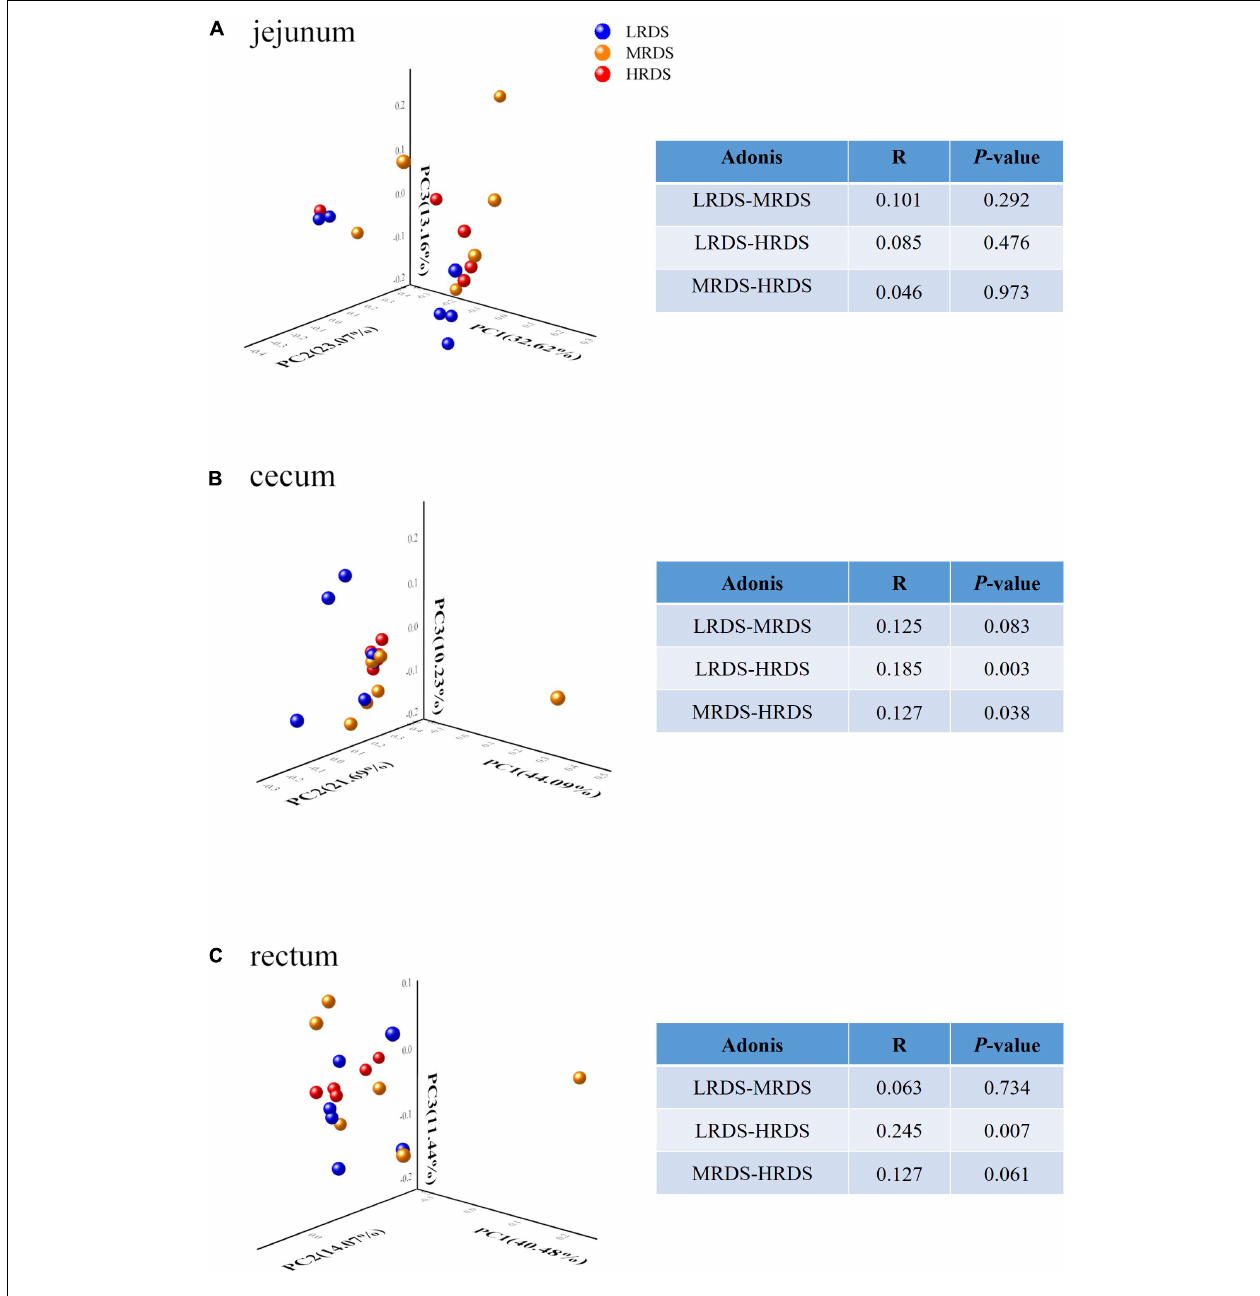
FIGURE 1 | Microbial community difference among different groups in the jejunum microbiome (A) , but showing obvious dysbiosis over positions in the cecum (B) and rectum microbiome (C) . The data represent the comparison of the gut bacterial profiles among the LRDS (blue), MRDS (yellow), and HRDS (red) groups. Principal coordinate analysis and Adonis scores computed for OTU taxon illustrating the grouping patterns based on the unweighted UniFrac distances. Distances between each pair of samples represent their dissimilarities. The R value represents the effect size indicating that the percent variation can be explained by RDS level. Only taxa meeting an LDA significant threshold > 2 are